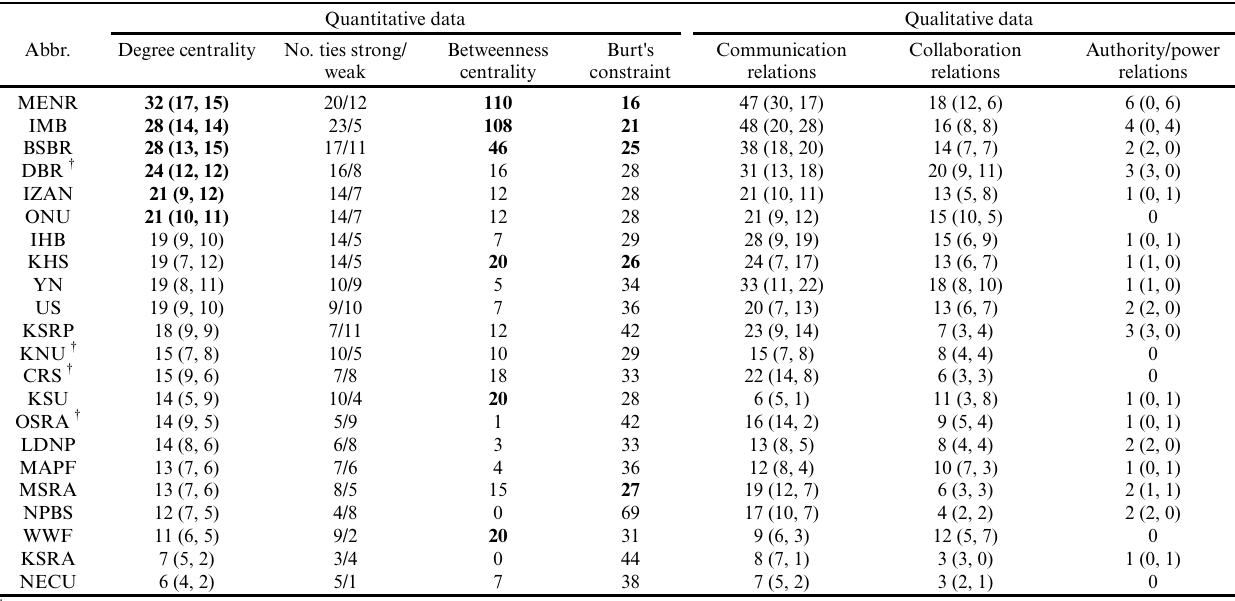
Table 3 . Node-specific measures. Values between brackets under “Degree centrality” represent the in-degree and out-degree measures, respectively. In bold are values higher than or equal to the third quartile threshold (lower than or equal to the first quartile threshold in case of “Burt’s constraint”). Numbers between brackets under “Qualitative data” represent the frequency of respective themes characterizing the incoming and outgoing